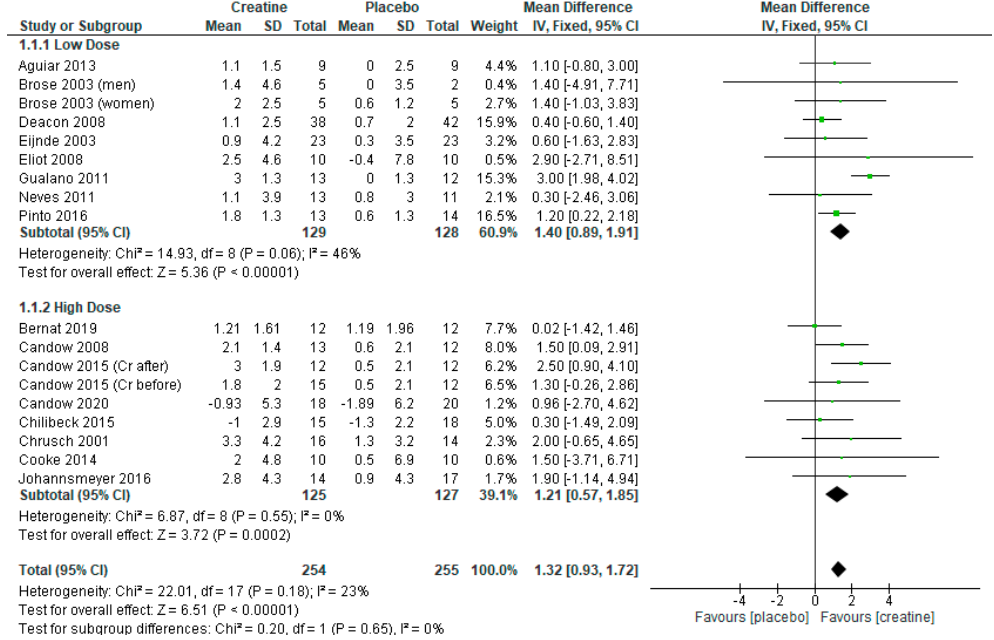
Figure 1. Forest plot of studies on lean tissue mass with sub-analyses using lower-dose creatine studies ( ≤ 5 g/day) and of higher-dose creatine studies (>5 g/day) on lean tissue mass.